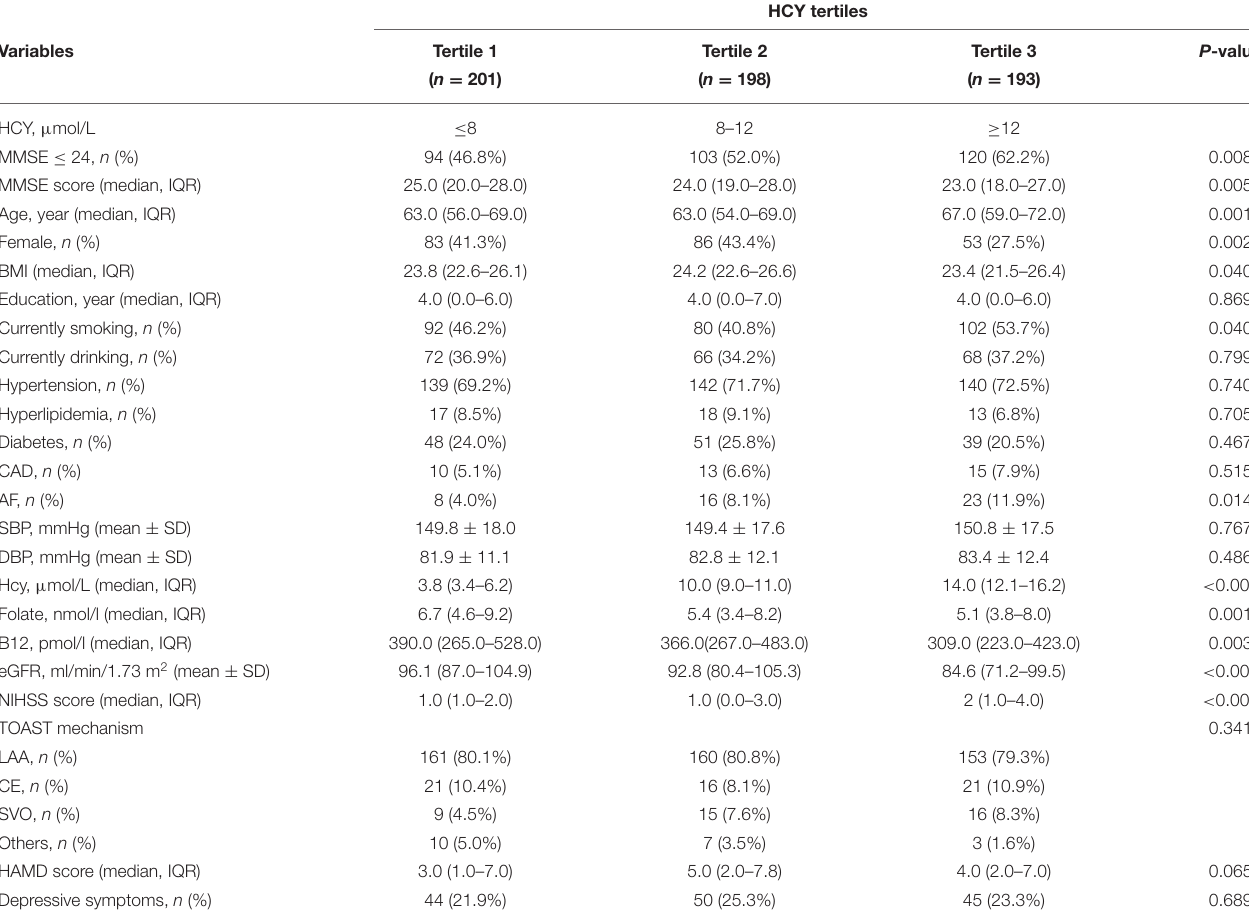
TABLE 2 | Baseline characteristics of patients with AIS in different HCY